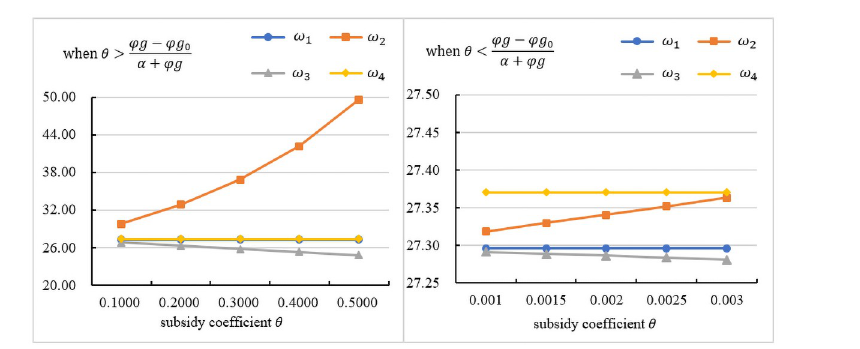
Fig 1. The influence of the subsidy coefficient on the wholesale price.